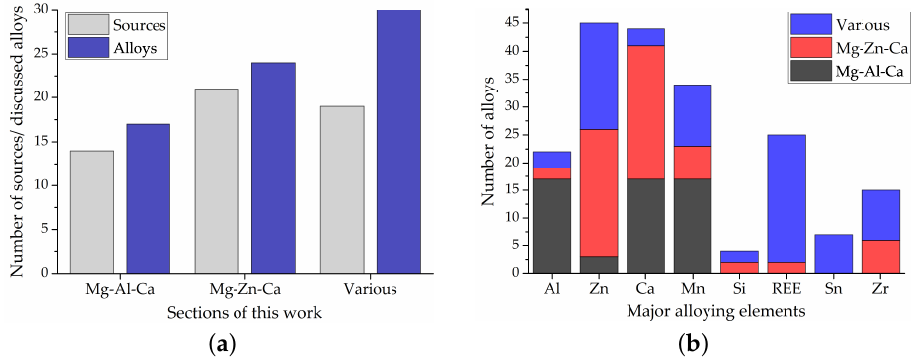
Figure 5. Overview of ( a ) the number of publications and alloys discussed in this work and ( b ) the number of alloys separated by major alloying elements found in this